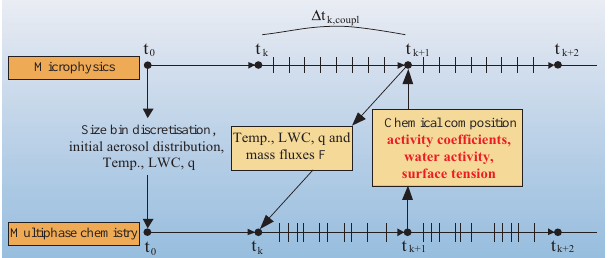
Figure 1. Schematic of the model coupling strategy and its imple- mentation considering the treatment of solution non-ideality and surface tension effects in